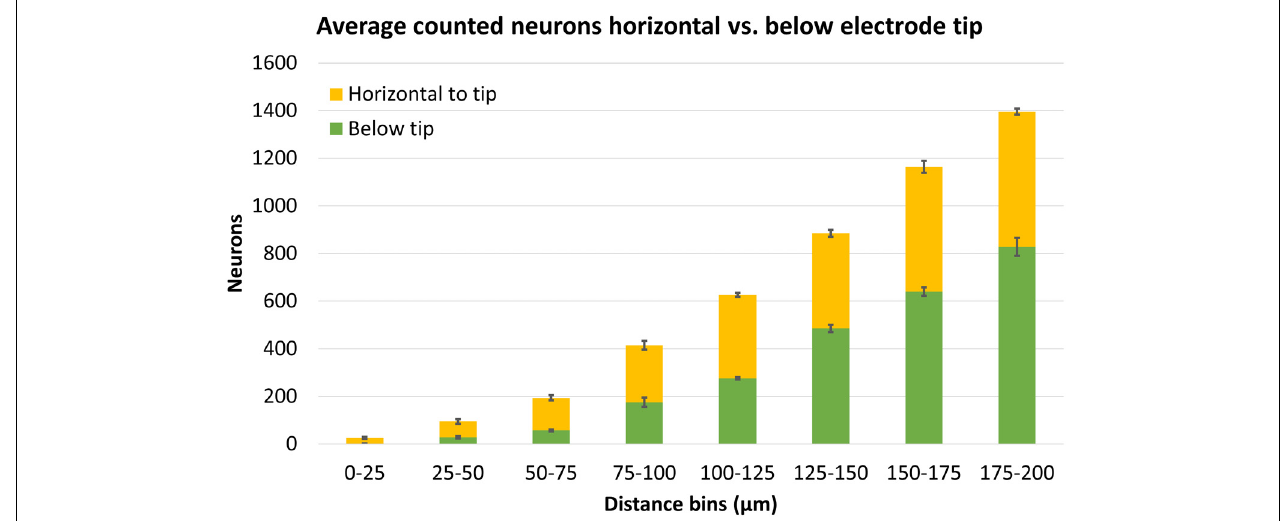
FIGURE 13 | Average neuron counts surrounding four Blackrock electrodes, split in two different depths: horizontal to the electrode tip, or below the electrode tip. Error bars show standard